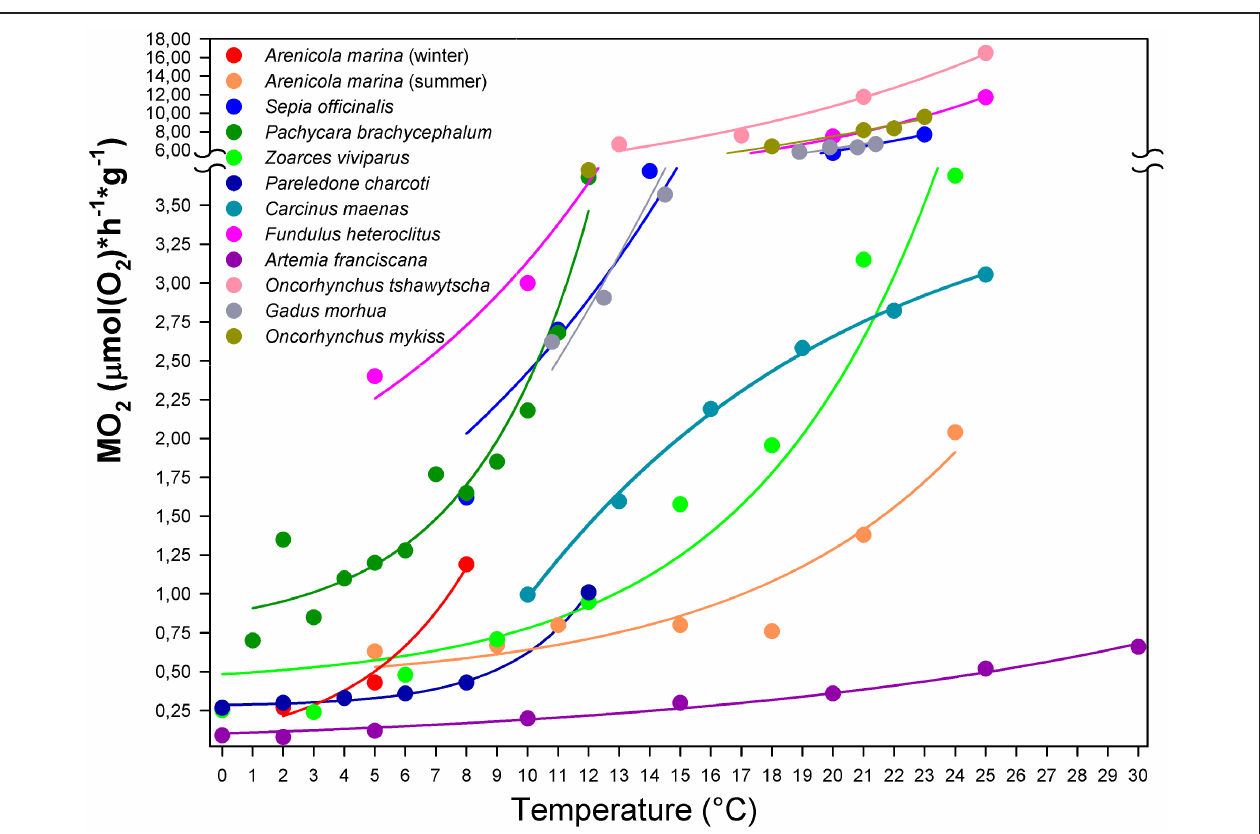
FIGURE 4 | Temperature-dependent rate of resting oxygen consumption for marine ectotherms. Typical metabolic trends reported for marine ectotherms match exponential curves turning into an asymptote, while approaching a maximum rate at a temperature, which likely corresponds to the species-specific critical temperature (Tc, as defined by the OCLTT concept). Upon further warming, metabolism decreases rapidly reflecting a failure in sustaining metabolic oxygen demand (data not shown). The temperature dependent oxygen consumption rate of Carcinus maenas (and possibly, other eurytherms) deviates from this general model. Non-linear regression fits the data better with an exponential rise to a maximum